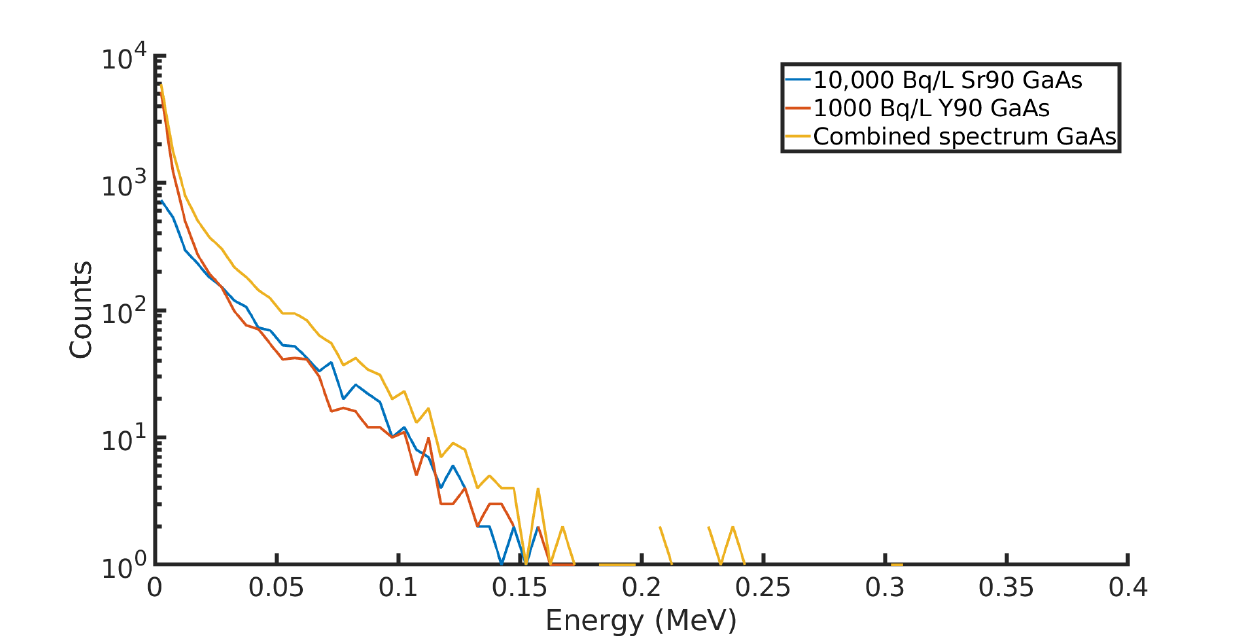
Figure 3. 90 Sr and 90 Y counts recorded in a CdTe detector in a groundwater borehole simulation. The combined spectrum is plotted in yellow.